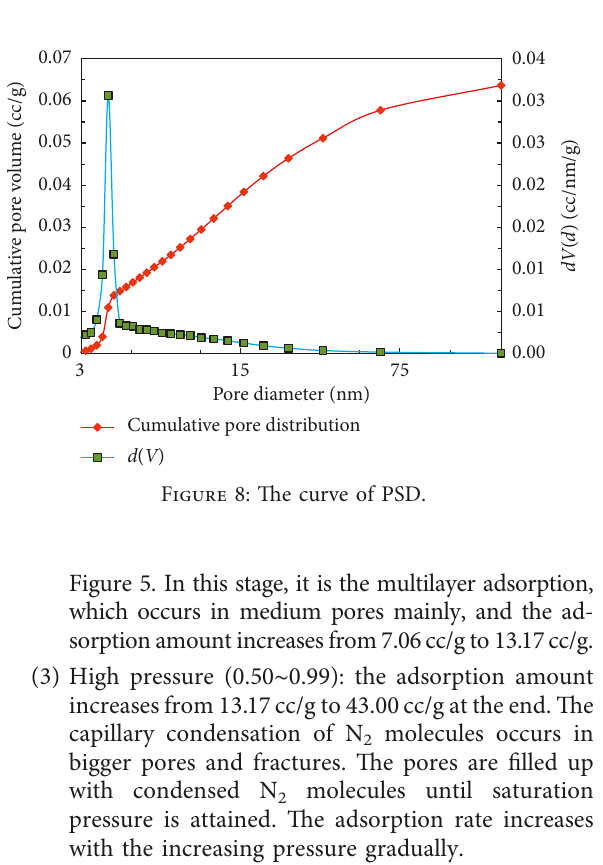
Figure 7: CR-A adsorption/desorption isotherm. P represents the absolute pressure, P 0 represents the saturation pressure of the adsorbent, CR-A-ad represents the adsorption process, and CR-A- de represents the desorption process.